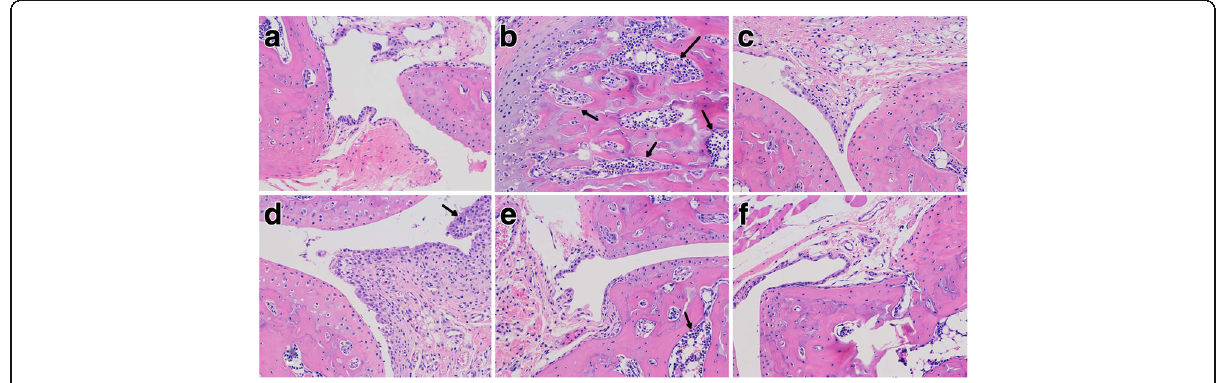
Fig. 6 Effects of G. pensylvanicum on pathological changes in paw surrounding tissue of mice. All sections were stained with H & E Stain (magnification A-F, ×200). a Blank group, ( b ) Model group with MSU, ( c ) Colchicine 1 mg/kg, ( d ) G. pensylvanicum 100 mg/kg, ( e ) G. pensylvanicum 200 mg/kg and ( f ) G. pensylvanicum 400